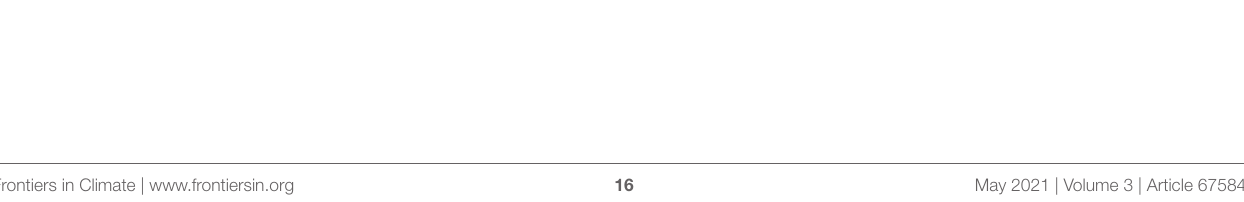
Frontiers in Climate |